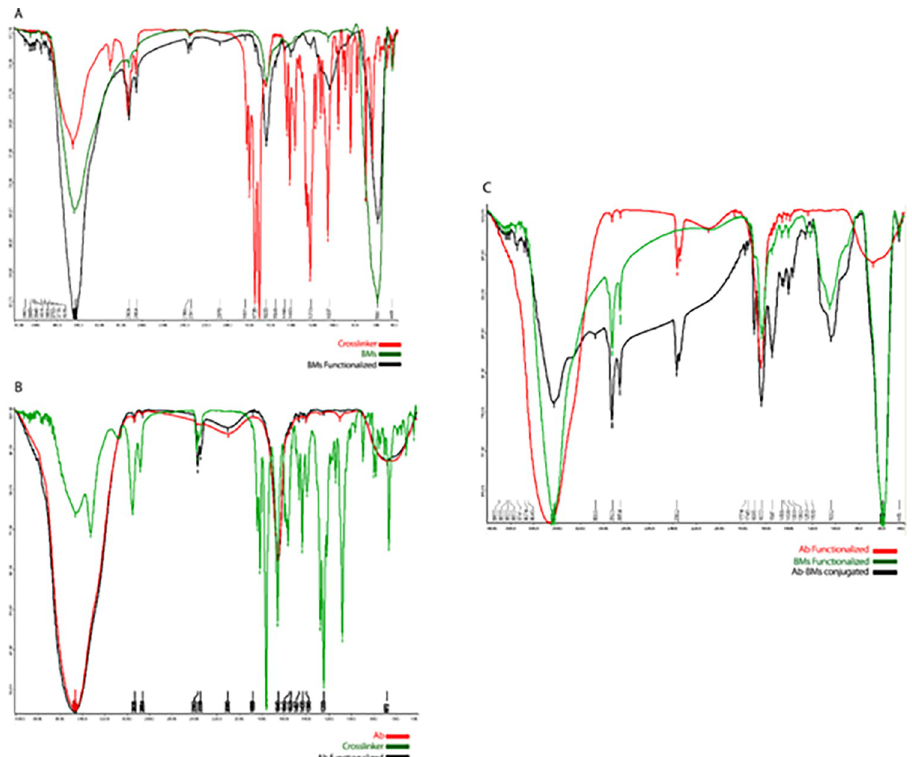
Fig 6. FTIR spectra of immobilization of Mab to BMs (IMA adsorbent), (A) BMs nanoparticles, Sulfo-LC-SPDP crosslinking agent and BMs functionalized (B) Mab, Sulfo SMCC crosslinking agent, Mab functionalized (C) BMs functionalized, Mab functionalized and Mab-BMs immobilized nanoparticles as a IMA